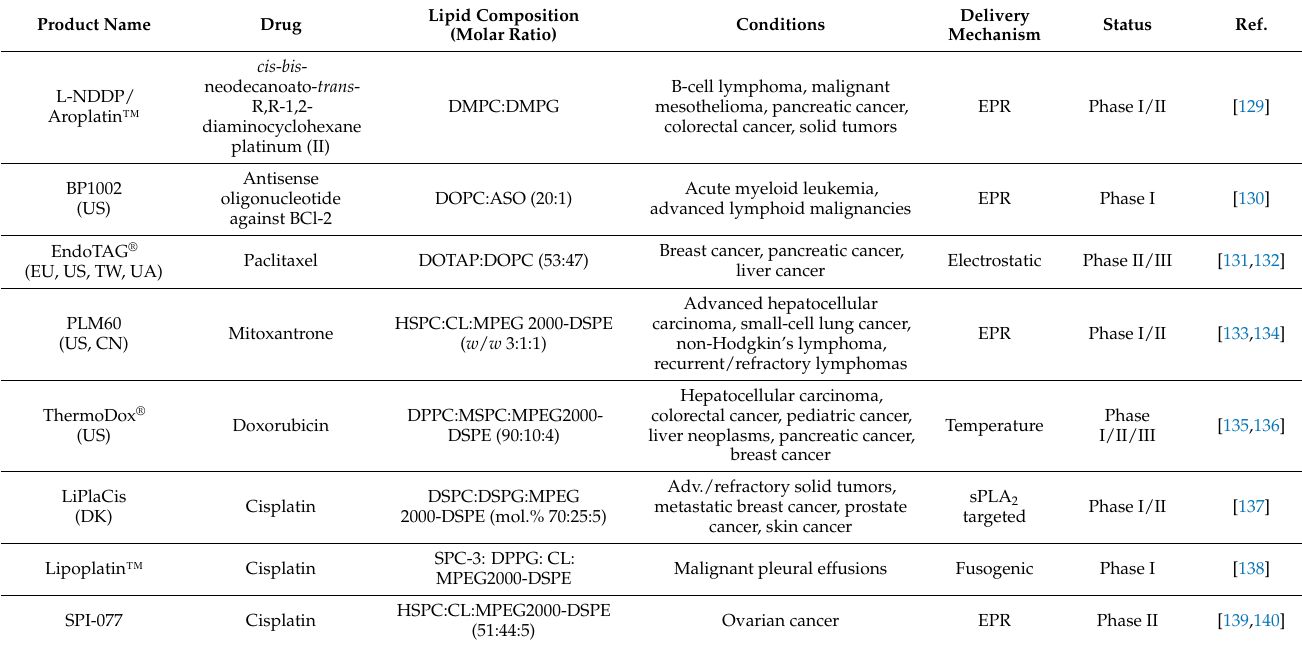
Table 2. Liposomal Drugs in Clinical Trials